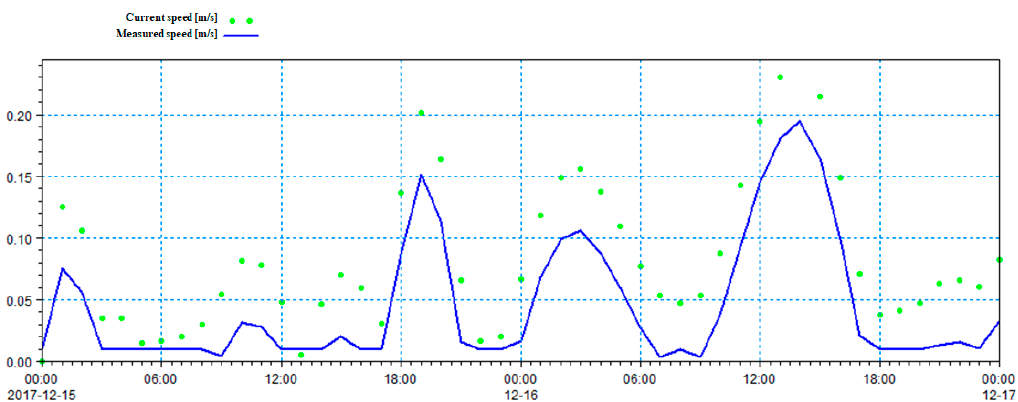
Figure 8. Results of flow rate verification at Xin ditch station.